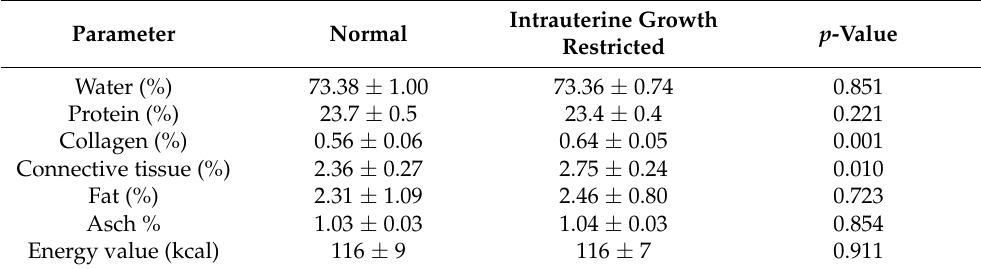
Table 3. Chemical composition and energy value of meat of normal ( n = 12) and intrauterine growth restricted ( n = 11) pigs. Mean ± SD, Student t